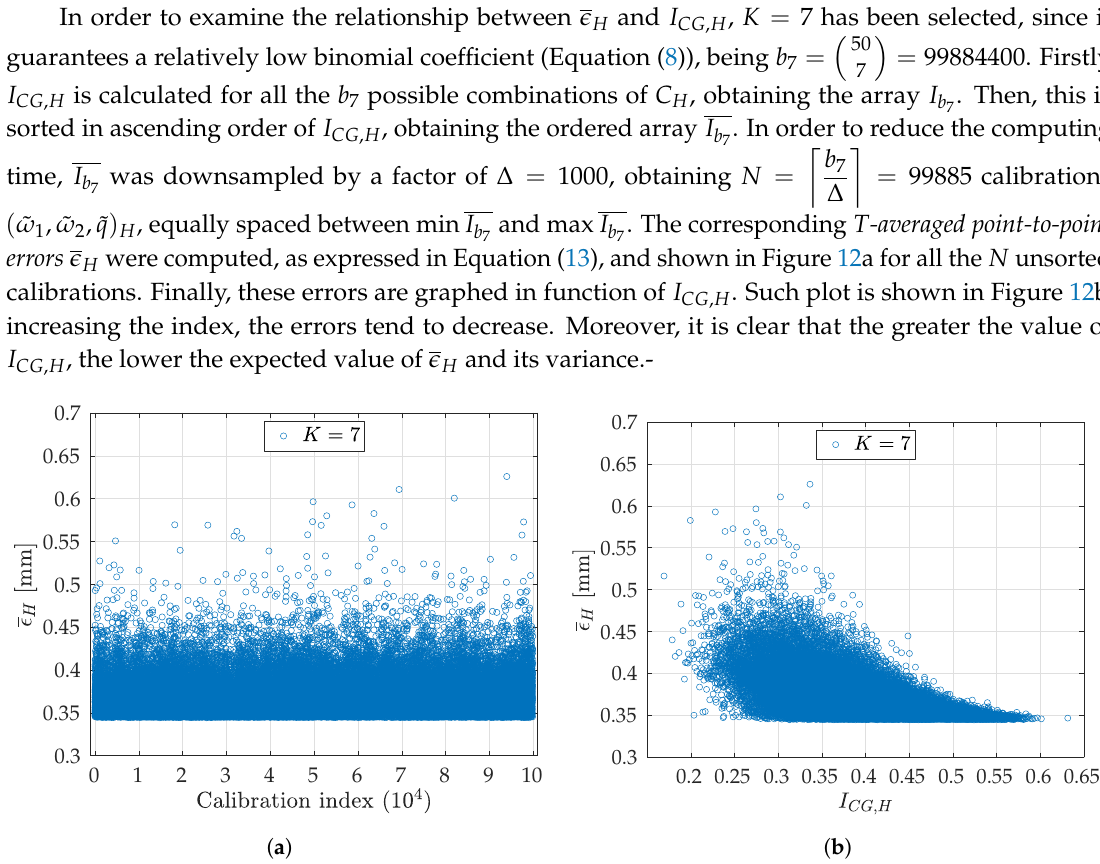
Figure 12. Relationship between (cid:101) H and I CG , H for N = 99,885 calibrations made using N C H subsets of K = 7 images. These subsets were uniformly downsampled by a factor of ∆ = 1000 among all the b 7 combinations of C H , then finally used for estimating ( ω 1 , ω 2 , q ) , thus obtaining N ( ˜ ω 1 , ˜ ω 2 , ˜ q ) H : ( a ) the order is the same as in ; ( b ) the order is the same as in I b I b 7 7